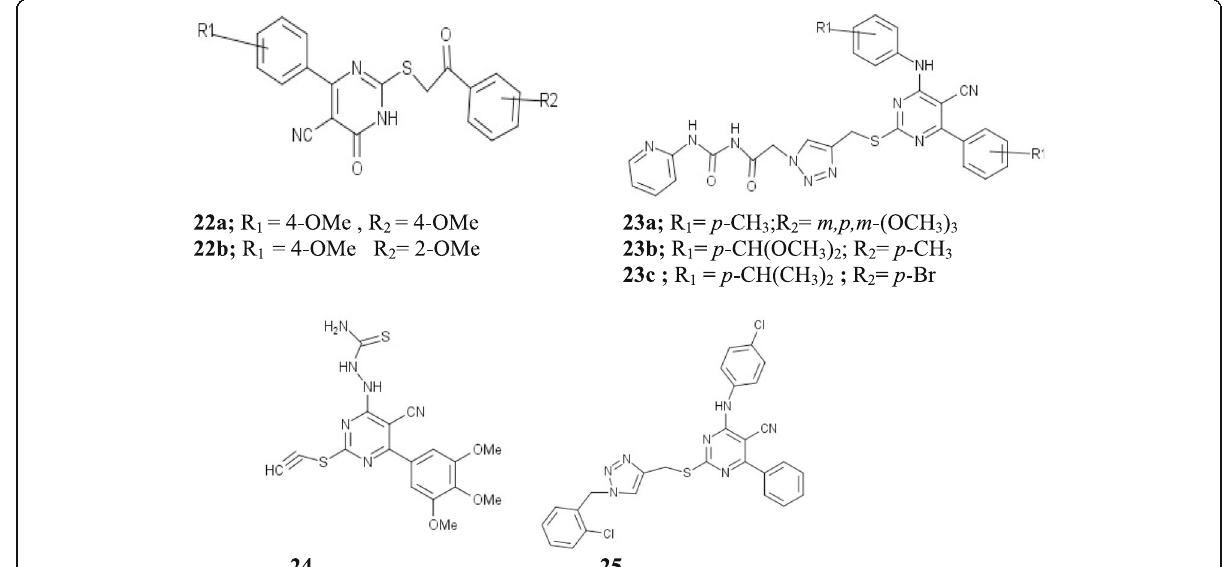
Fig. 9 Chemical structures of tetrasubstituted pyrimidine